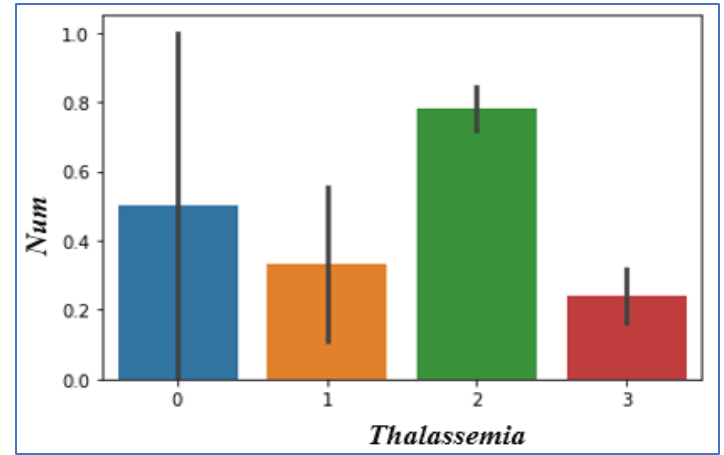
Figure 12. Thalassemia vs. heart disease chances.